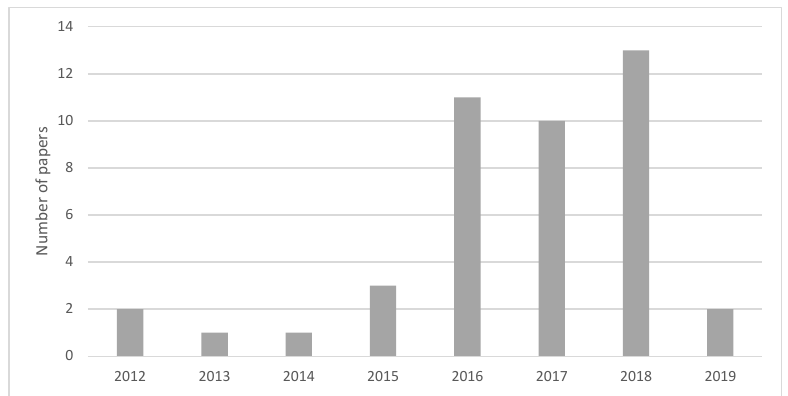
Figure 1. Year of publication.